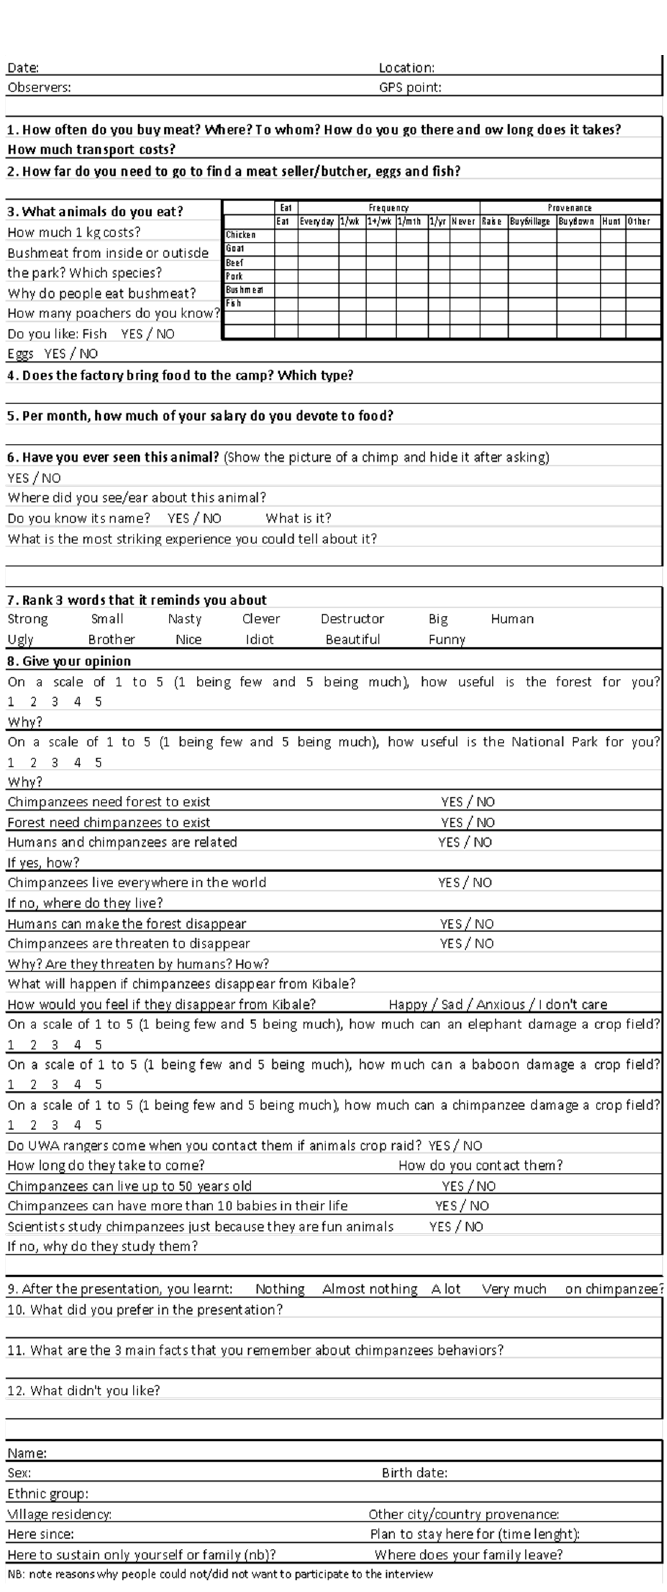
Figure A2. Interview form used around Sebitoli area, Kibale National Park, Uganda.